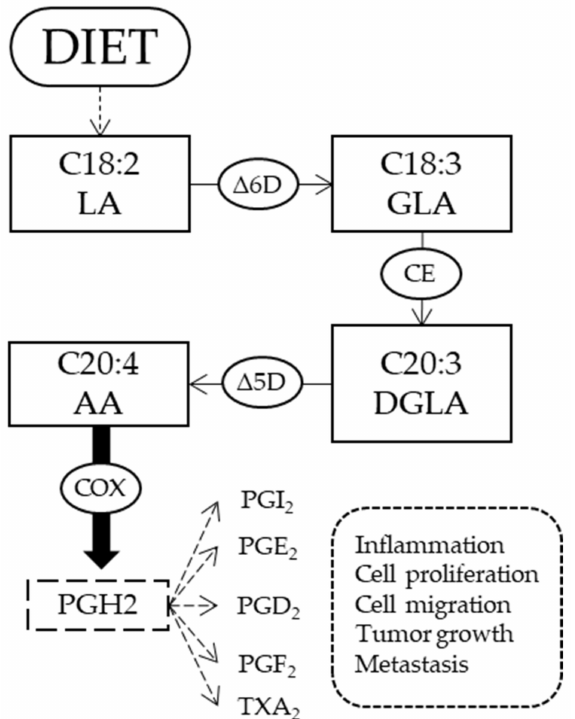
Figure 1. Metabolic pathway of ω -6 fatty acids. Linoleic acid (LA) comes from diet, and through ∆ -6 desaturase enzyme forms gamma-linoleic acid (GLA). Then, an elongase (CE) adds two carbon atoms to form dihomo- γ -linolenic acid (DGLA) that, with the action of ∆ -5 desaturase, produces arachidonic acid (AA). AA through cyclooxygenase (COX) enzymes is the precursor of some prostaglandins (PG), as the H 2 , I 2 , E 2 , D 2 , F 2 and the thromboxane (TX) A 2 involved in di ff erent processes associated with